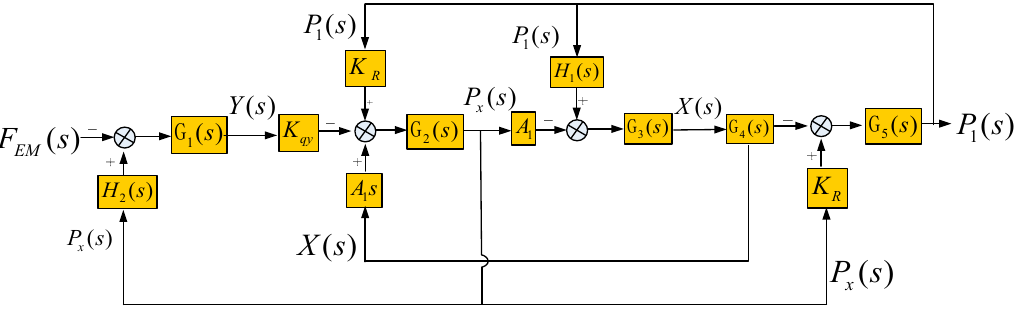
Figure 5. Block diagram of traditional proportional relief valve control system.